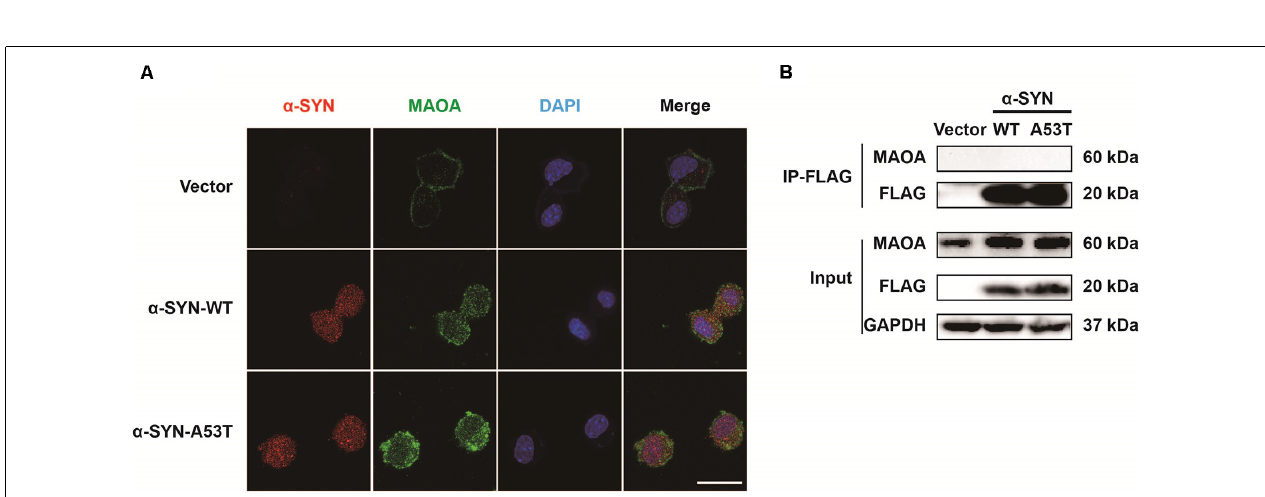
FIGURE 2 | Colocalization and interaction of α -SYN and MAOA. The intracellular protein level of MAOA was detected using immunofluorescent staining, α -SYN (red), MAOA (green), and nucleus (blue). Scale bare: 20 µ m (A) . The transfected α -SYN was pulled down with an anti-FLAG antibody, and the direct binding between α -SYN and MAOA was detected in the control cells (Vector), α -SYN-WT and α -SYN-A53T stable expression cells (B) .